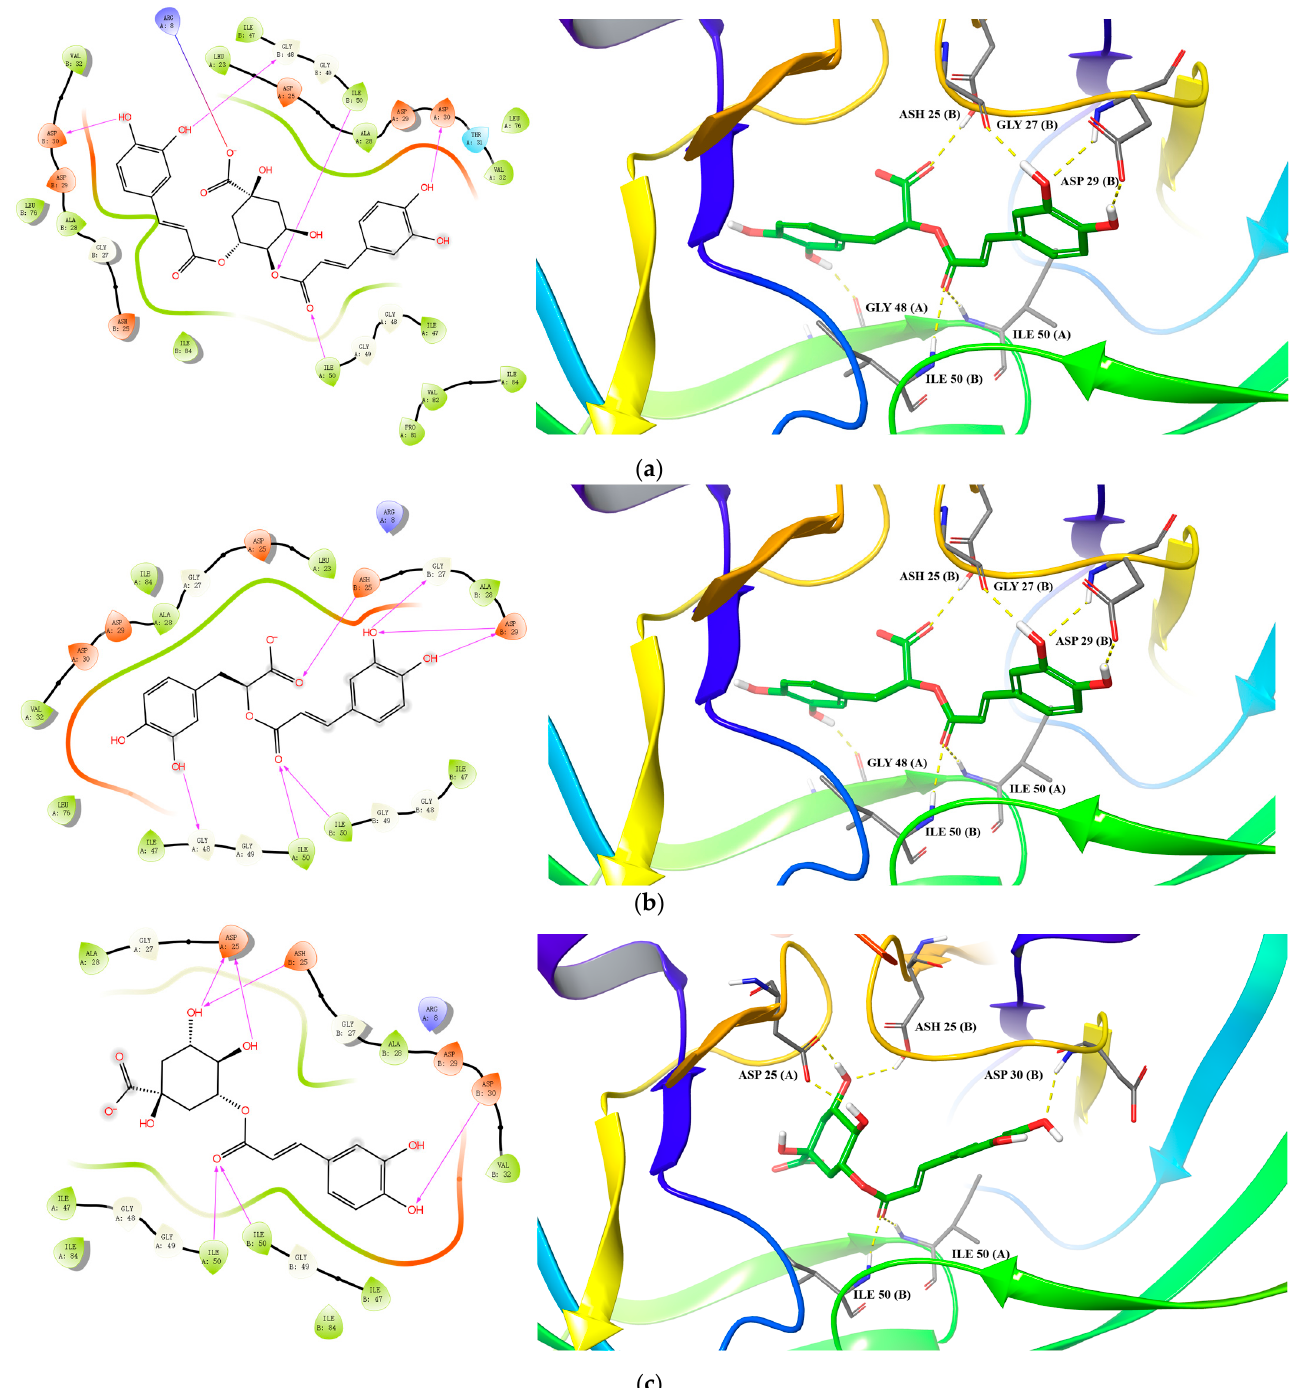
Figure 4. Predicted binding of 3,4-dicaffeoylquinic acid ( a ), rosmarinic acid ( b ), and chlorogenic acid ( c ) to HIV-1